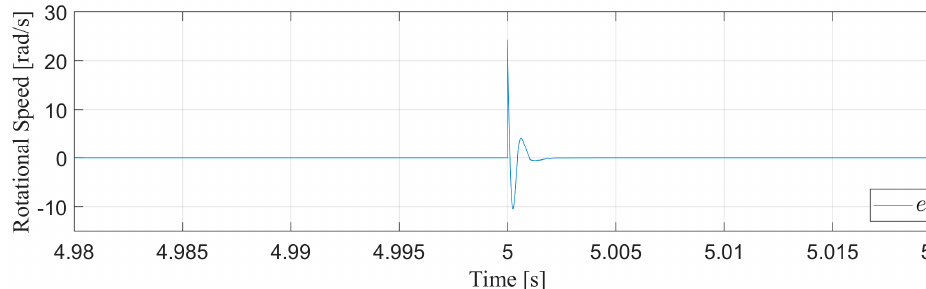
Figure 6. Speed error during wind step.